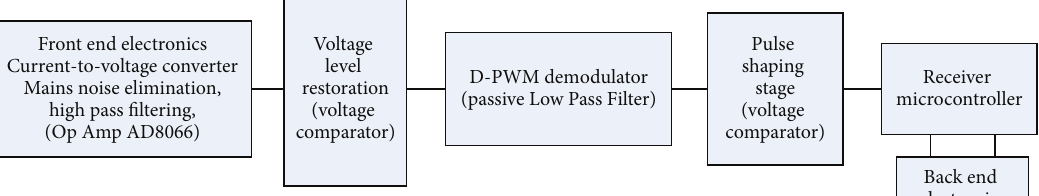
Figure 4: Stages (block diagram) of the receiver.